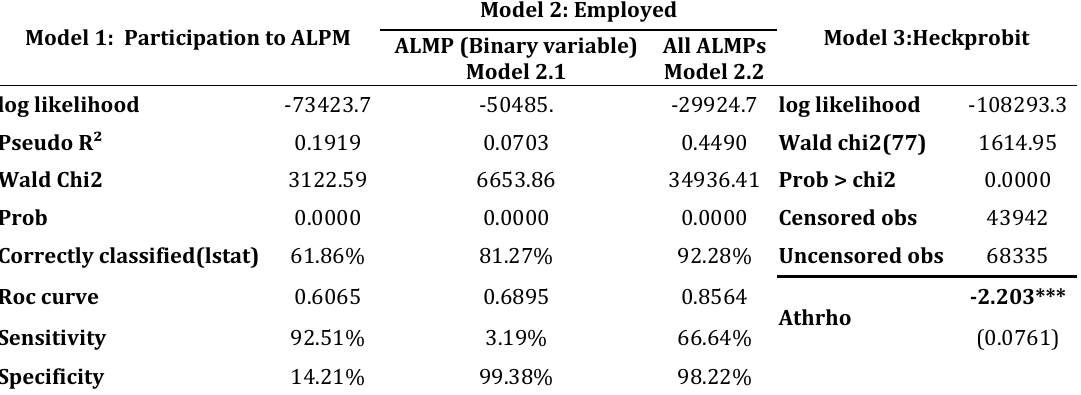
Table 1: Explanatory power of the estimated